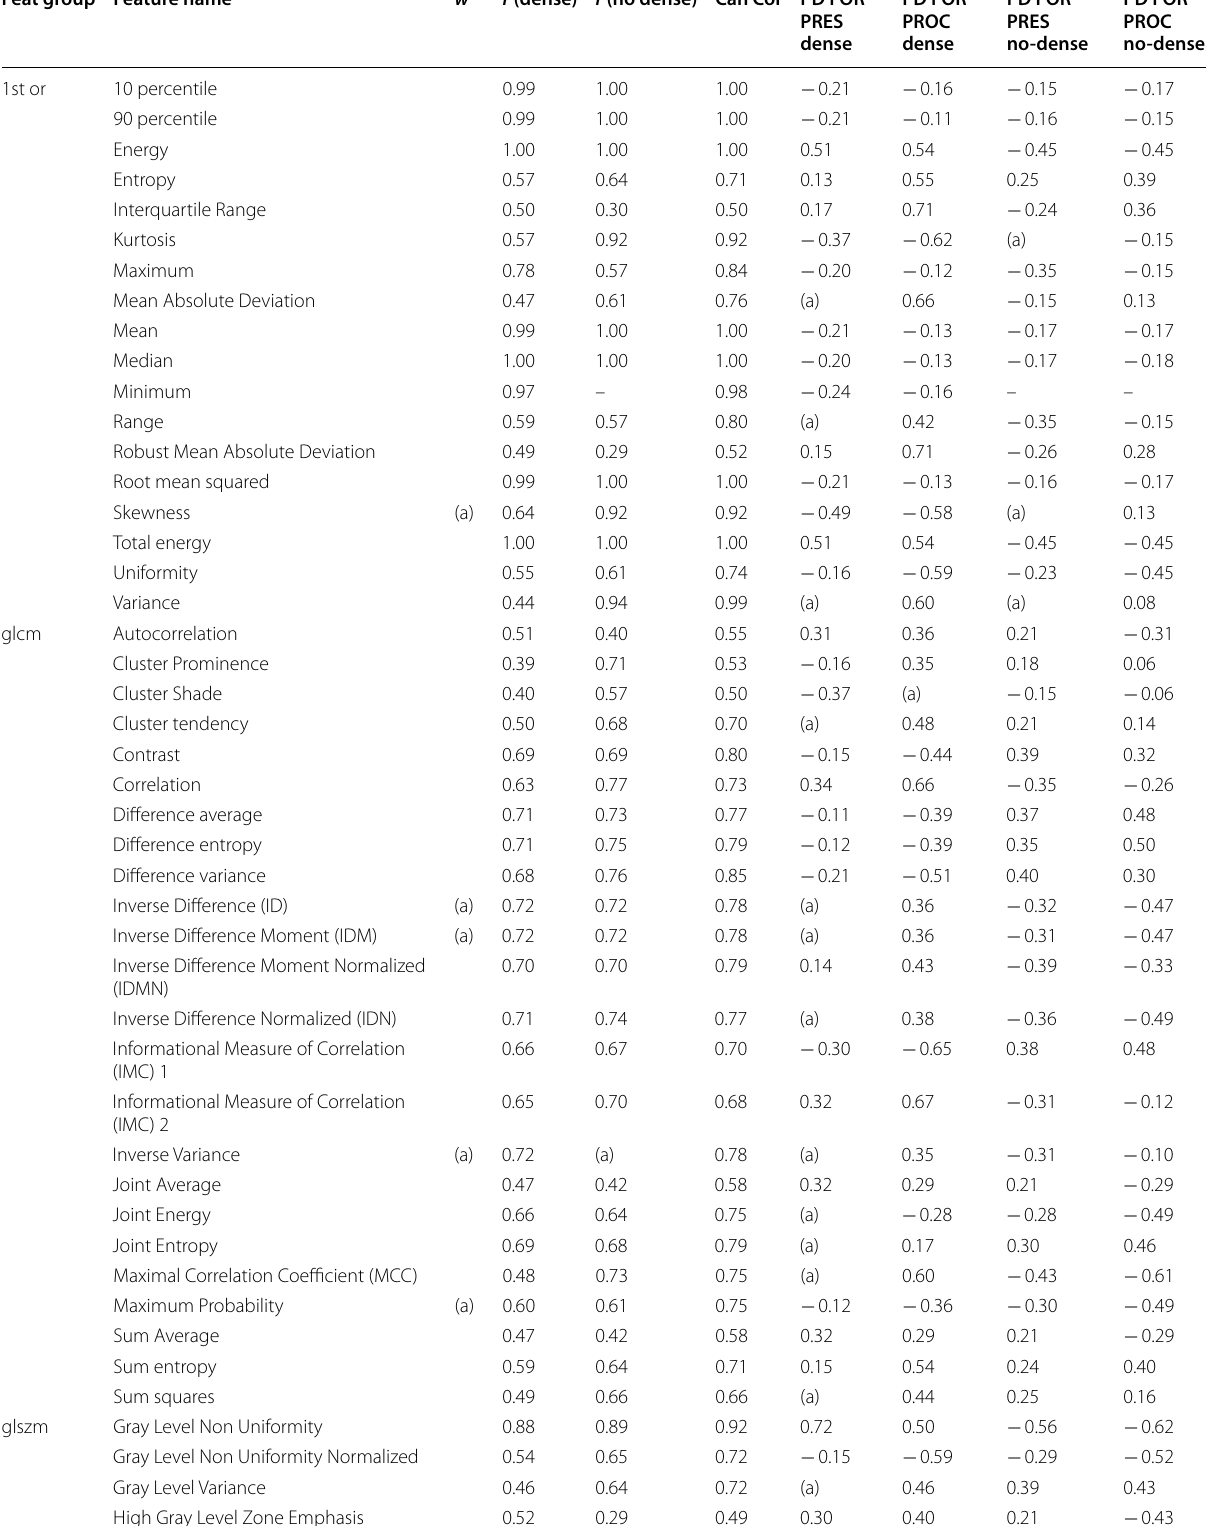
Table 3 Comparison between FOR-PROCESSING and FOR-PRESENTATION features computed on “dense” area and “non-dense” area Feat group Feature name w r (dense) r (no dense) Can Cor PD FOR